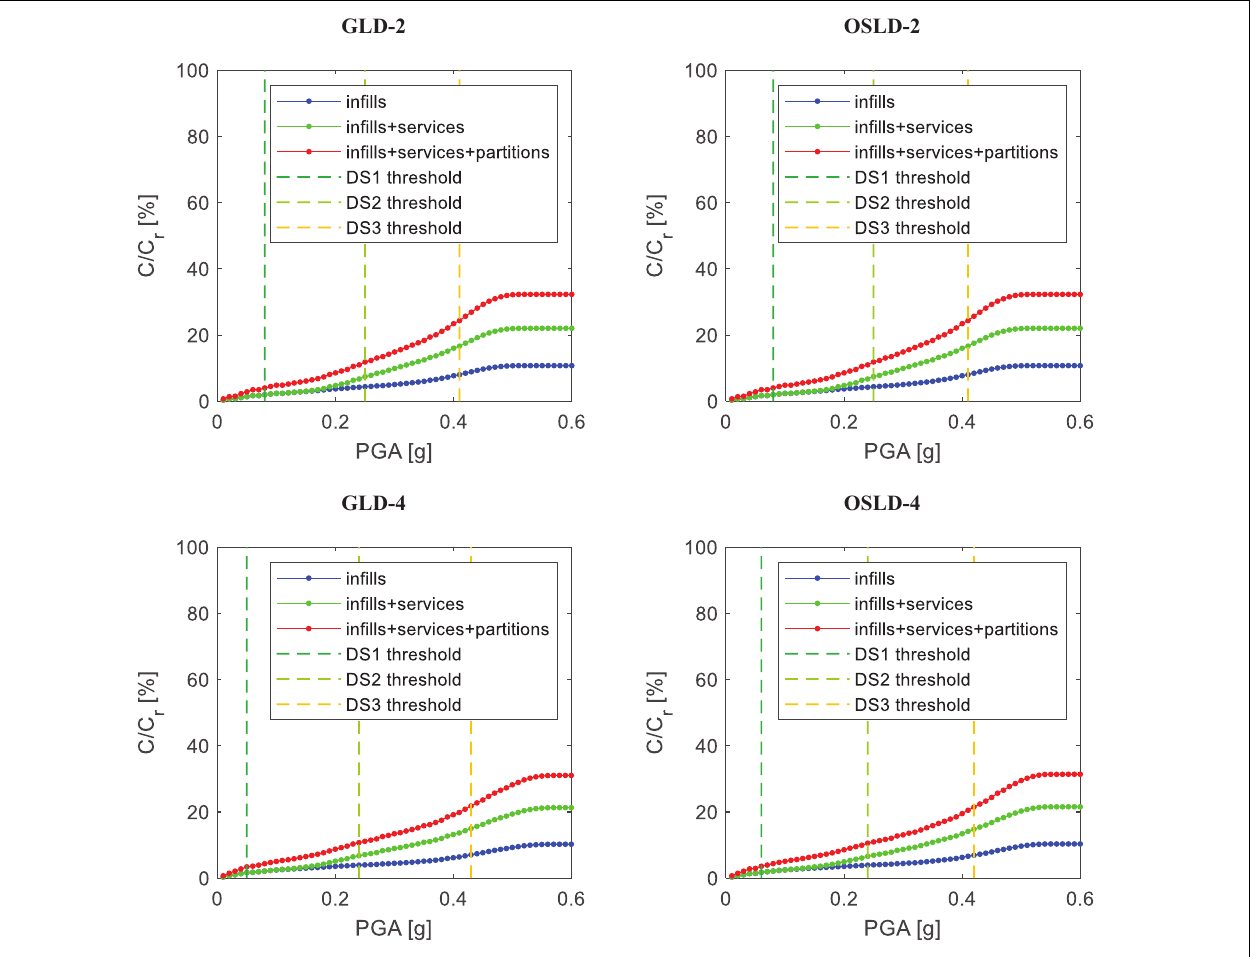
FIGURE 13 | Total building repair cost C -to-reconstruction cost (C r ) ratio trends depending on